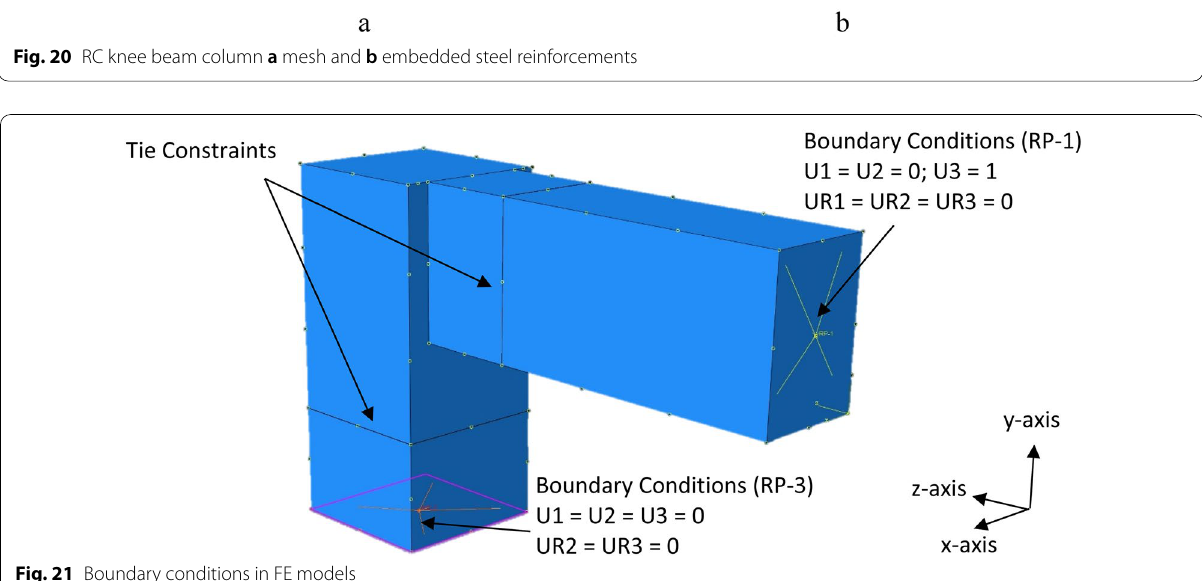
Fig. 21 Boundary conditions in FE models